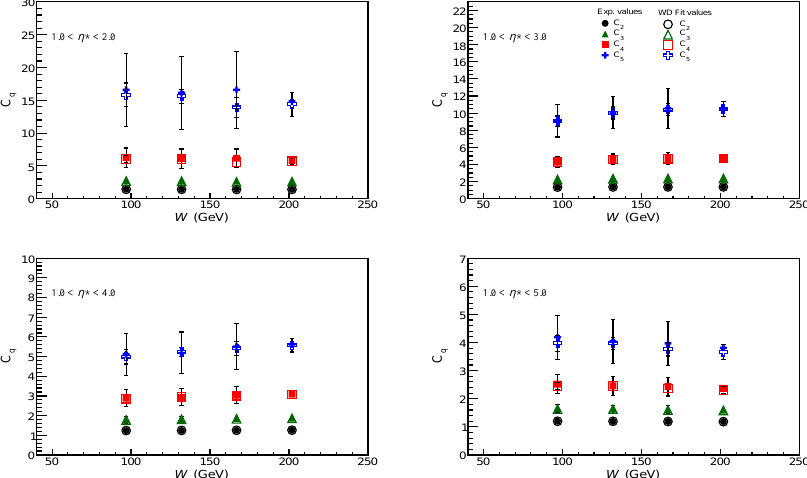
Figure 11. Normalized moments C q for q = 2, 3, 4, 5 for the WD fits and comparison with the values calculated from the data in different η ∗ ranges of H1 data